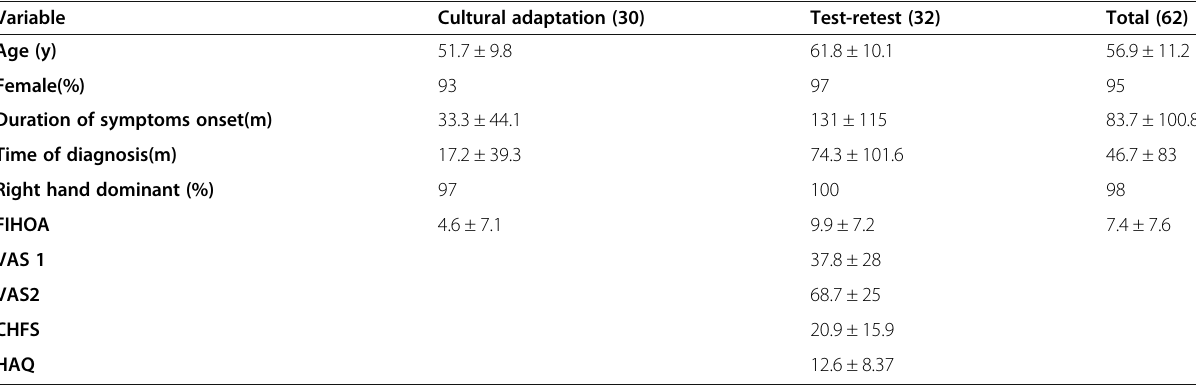
Table 2 Demographic and clinical characteristics of patients that answered the Portuguese version of the FIHOA questionnaire